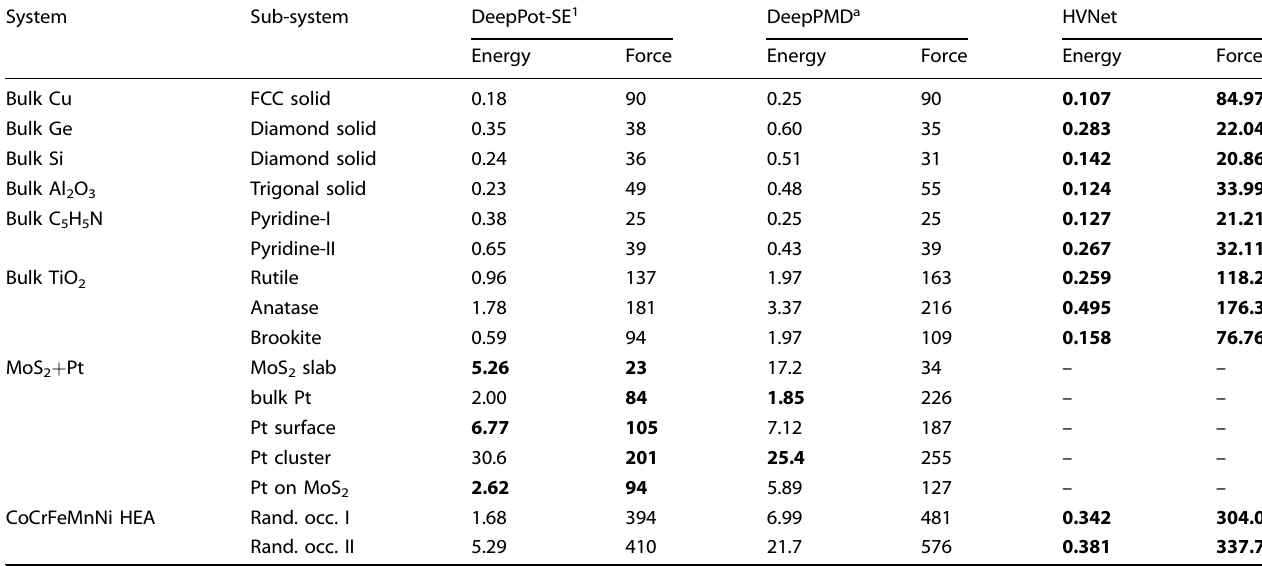
Table 3. Comparison of the root mean square errors between DeepPot-SE (DeePMD) and HVNet trained on extended systems dataset, where the root mean square errors of the energies are normalized by the number of atoms in the system (energies in meV and forces in meV Å − 1 ). System